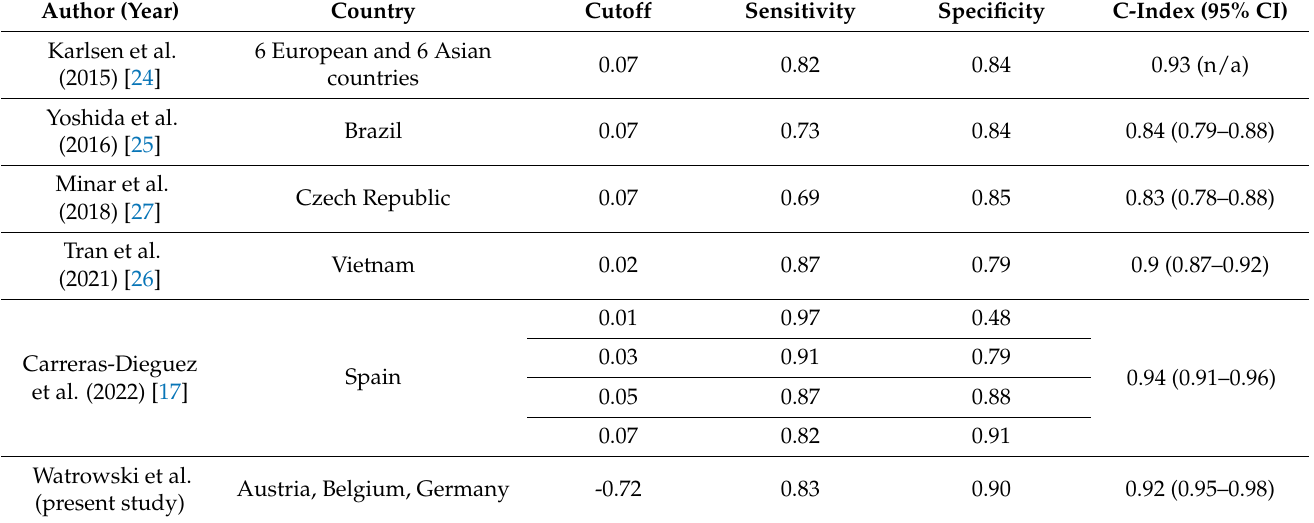
Table A4. Discriminative ability (at the optimal cut-point) of CPH-I in validation